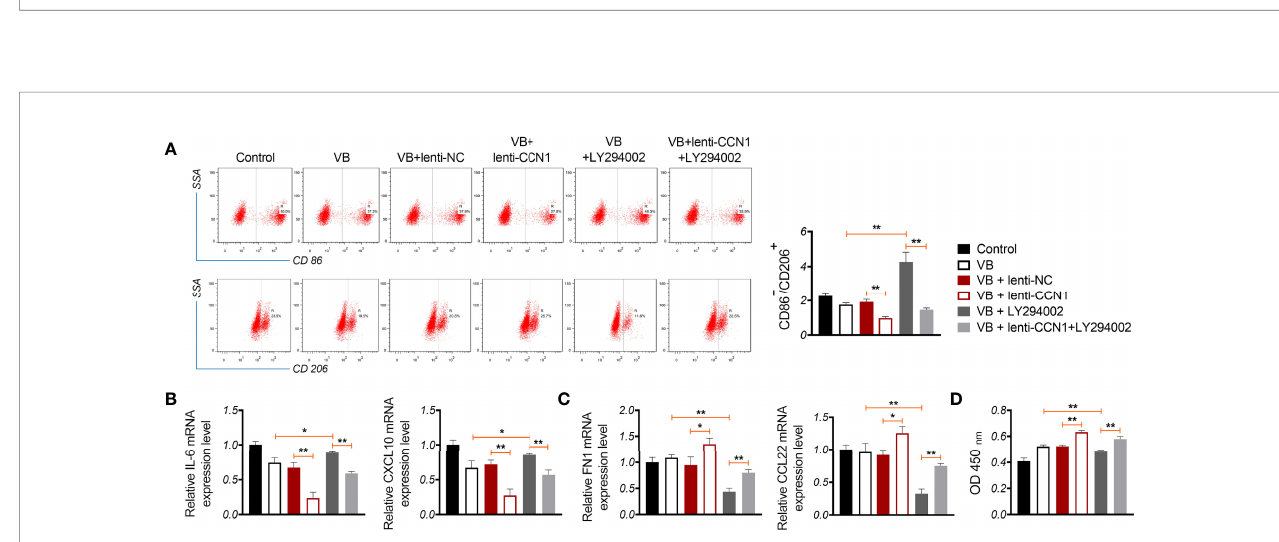
FIGURE 5 | VB promotes M1 polarization by affecting CCN1-mediated AKT/NF- k B pathway. (A) The CD86 + and CD206 + ratio in macrophages were measured by fl ow cytometry. (B, C) The relative expression levels of IL6, CXCL10, FN1, and CCL22 were examined by RT-qPCR. (D) The proliferation of A2780 cells was detected by CCK8 assay. A2780 cells were co-cultured with THP-1 macrophage and treated with LPS + IFN- g , 20 µM VB, lenti-NC, lenti-CCN1, or/and LY294002. Data are expressed as the mean ± SD; * P < 0.05 and ** P <